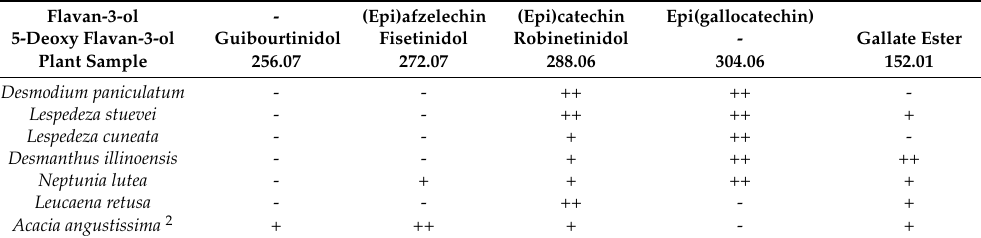
Table 3. Interval between clusters of peaks in MALDI spectra 1